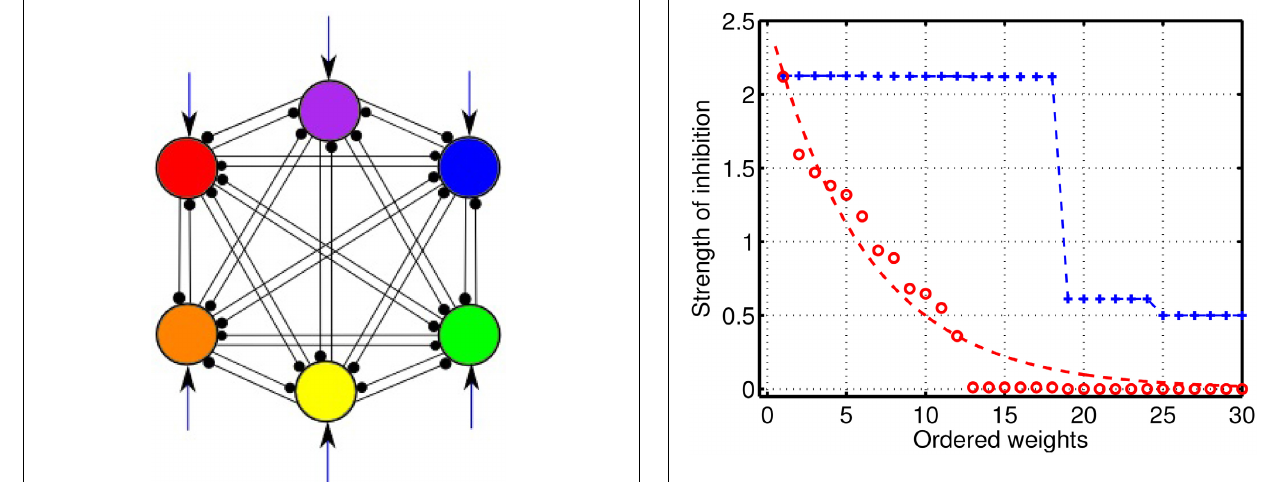
FIGURE 3 | Distribution of the strengths of the inhibitory connections in the GLV network with 6 participants. Blue: connectivity in a network producing normal SHC behavior; the large weights represent two triangle motifs with strong constant connectivity values, while there is a group of small weights describing weak connectivity between the motifs. Red: illustrates the pathological case with significantly reduced inhibitory connections with respect to normal SHC case, which are distributed over the parameter range; the dotted red line is a simple exponential fit shown for better